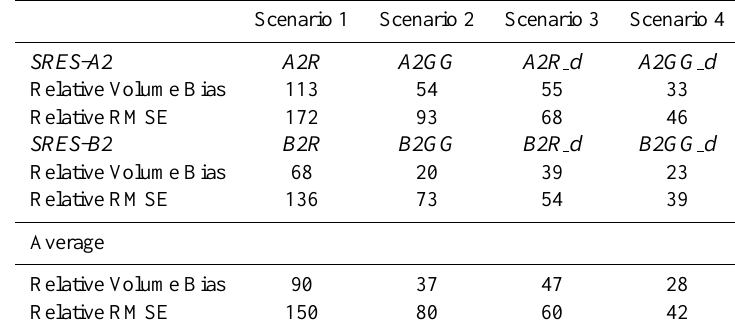
Table 6. Relative volume bias (%) and relative RMSE (%) in streamflow